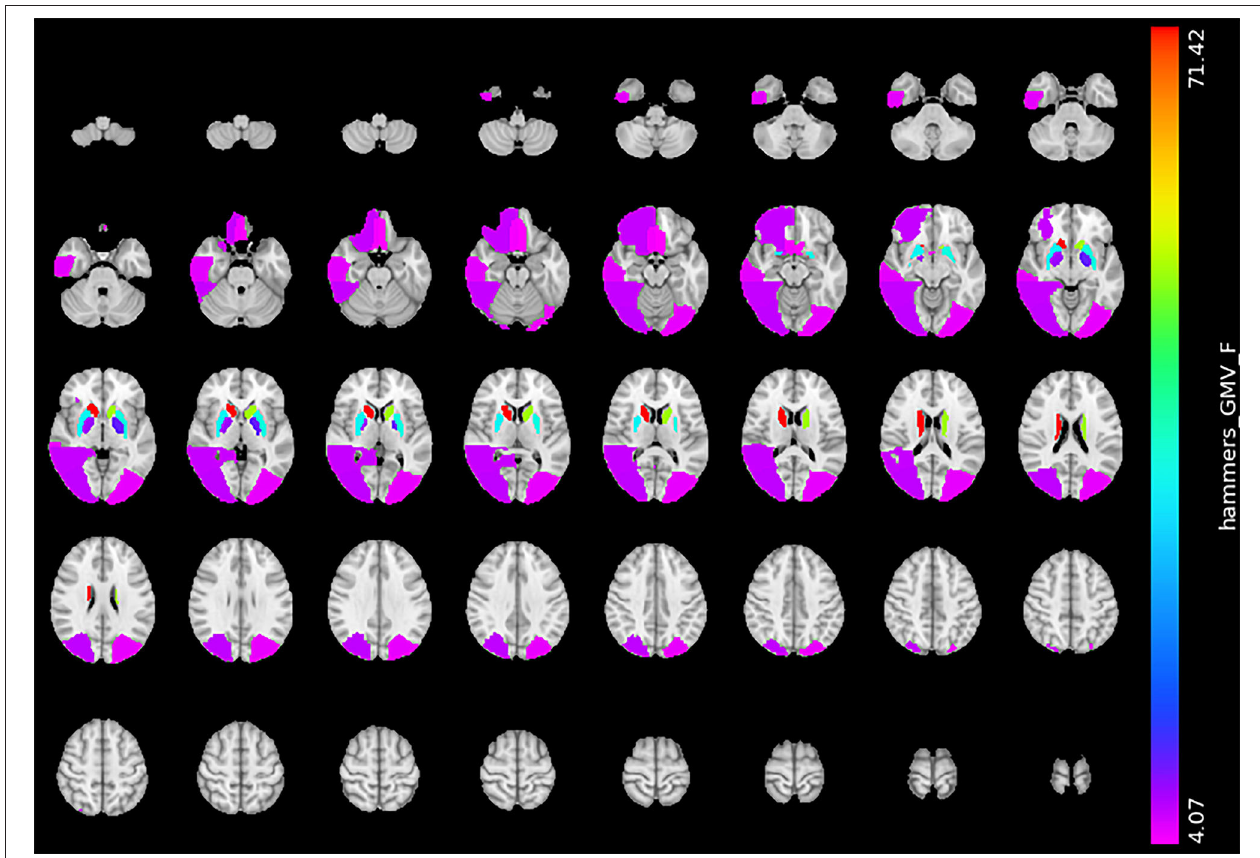
FIGURE 3 | Significant difference in GMV between the mild BG-PVS group and the severe BG-PVS group. The severe BG-PVS group shows a significantly smaller volume in multiple cortical areas and a larger volume in the bilateral caudate nucleus, pallidum, and putamen ( P FDR < 0.05, corrected for age, sex, scanner and TIV). The F-score bar is shown on the right. The left part of the figure represents the individual’s right side. GMV, gray matter volume; BG-PVS, basal ganglia perivascular spaces; TIV, total intracranial